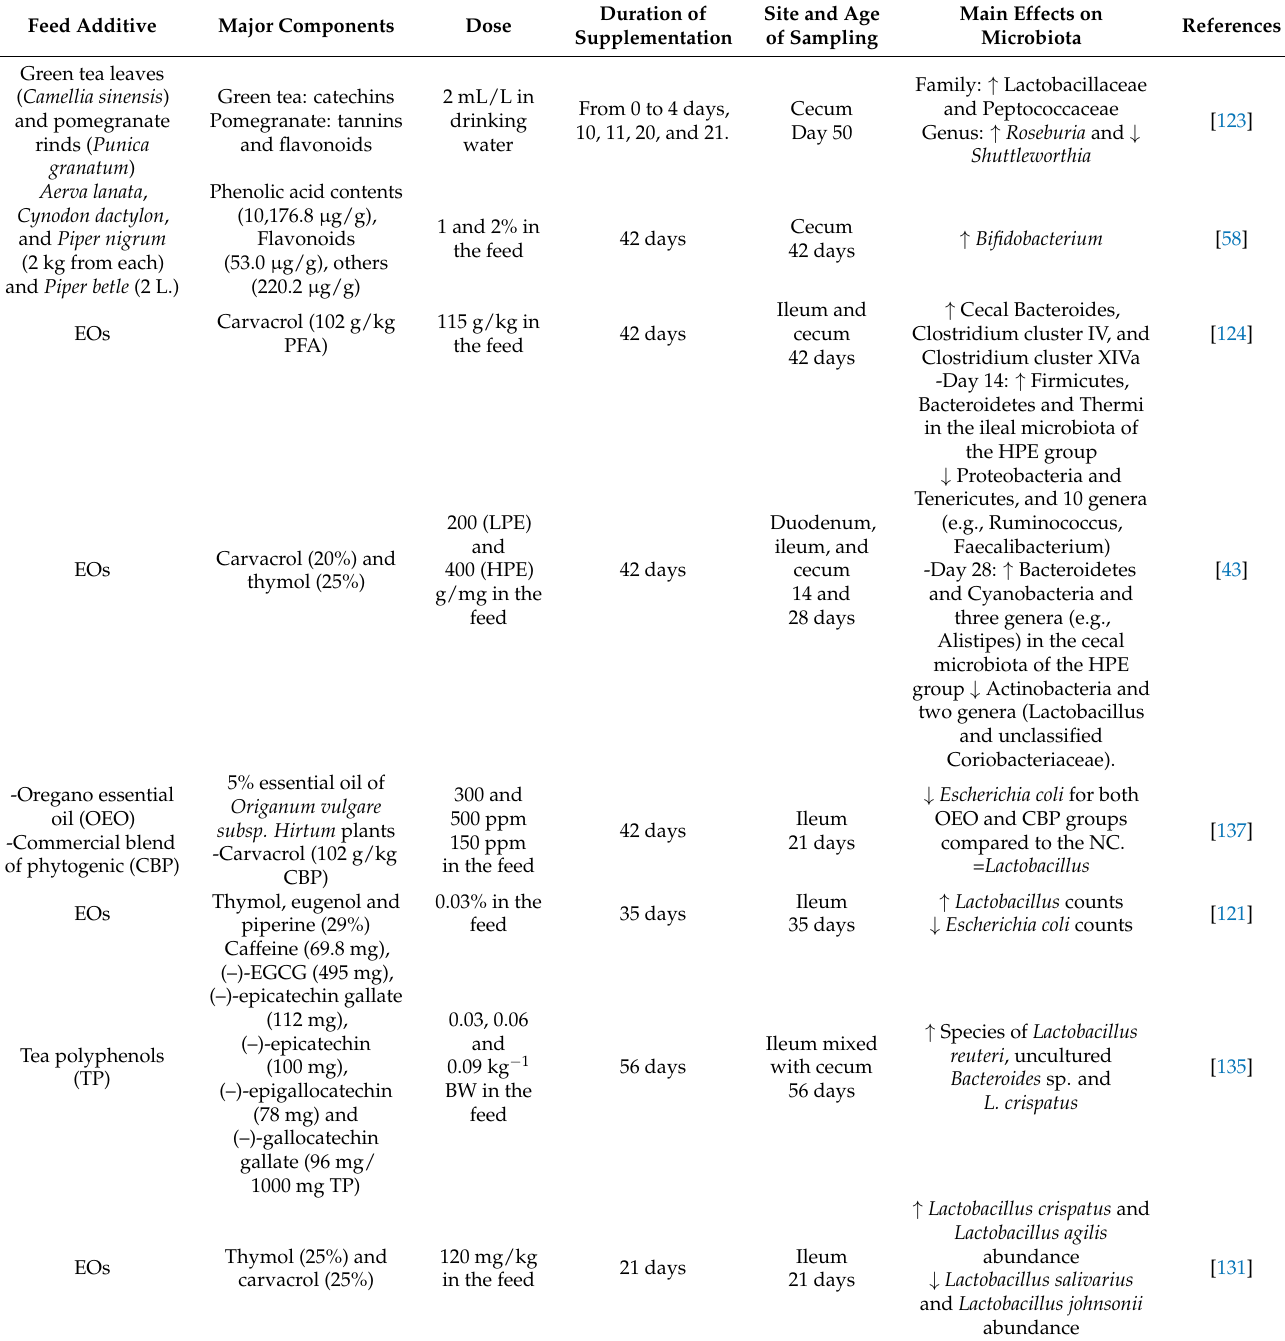
Table 5. Effects of dietary PFA supplementation on microbiota of